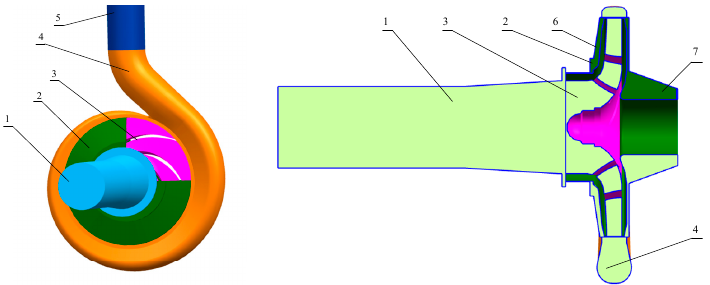
Figure 1. Simulation pump model. 1. Inlet section; 2. pump cavity; 3. impeller; 4. volute; 5. outlet section; 6. front cavity and 7. rear cavity.